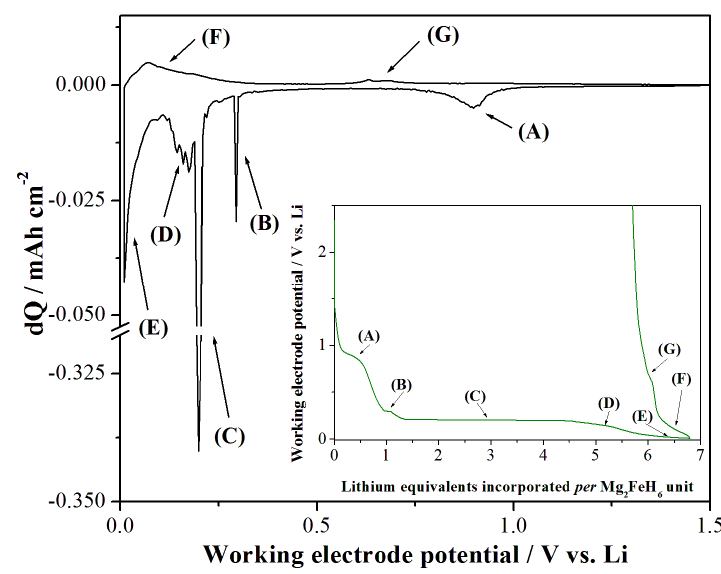
Figure 4. Differential capacity plot obtained in the PCGA test performed on the Mg 2 FeH 6 material (RBM sample after H 2 sorption at 485 °C) (composite electrode: AM:SP:Binder = 5:3:2). In the inset, the corresponding lithium loading/extraction curves are shown. Labels (A) to (G) identify the occurrence of electroactive processes.